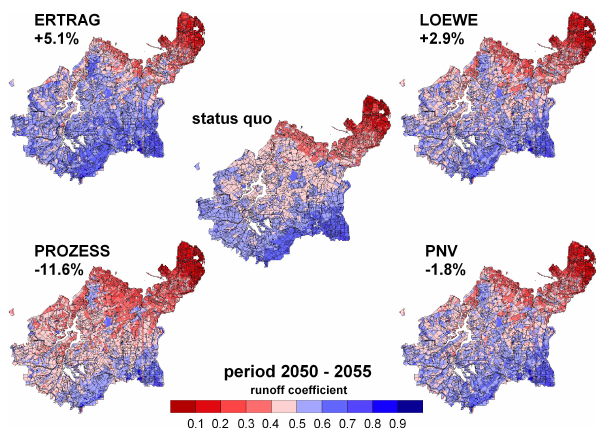
Fig. 5. Runoff coefficient for different forest development